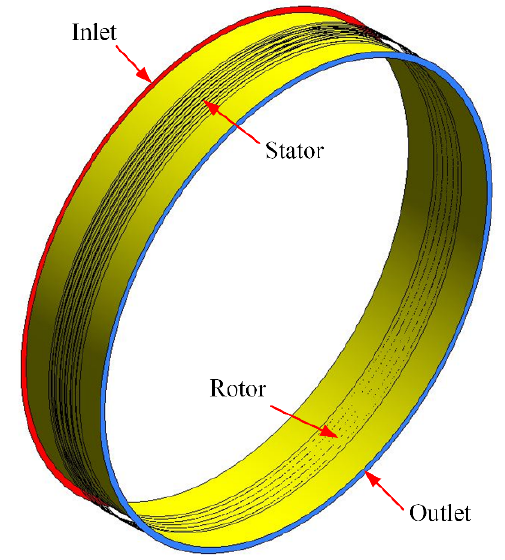
Figure 9. Computational model of labyrinth seal.